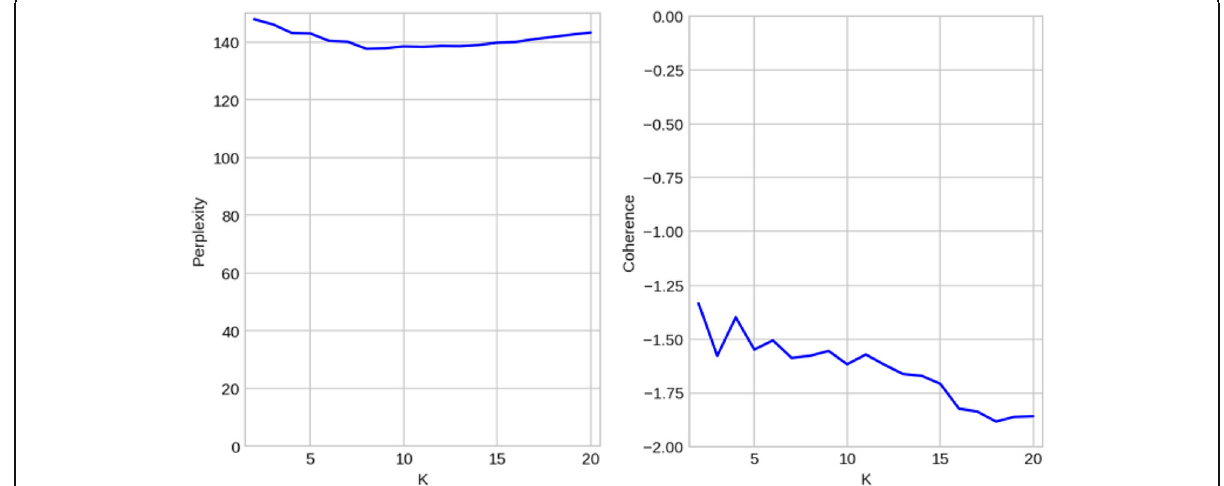
Fig. 5 Perplexity and coherence indexes with different numbers of topics